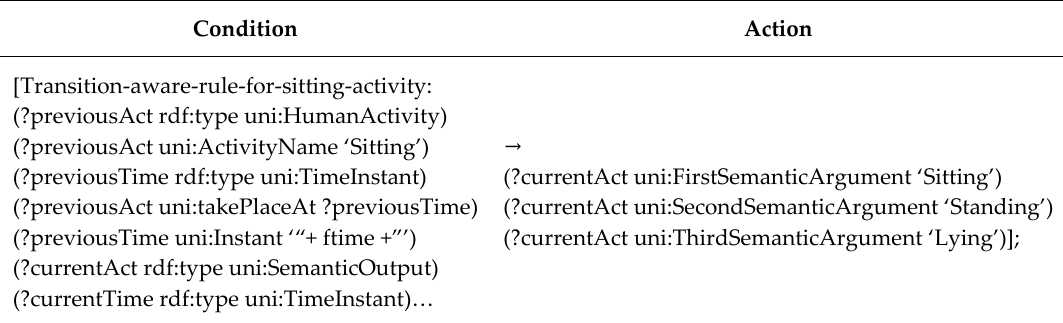
Table 3. Transition-aware rule representation